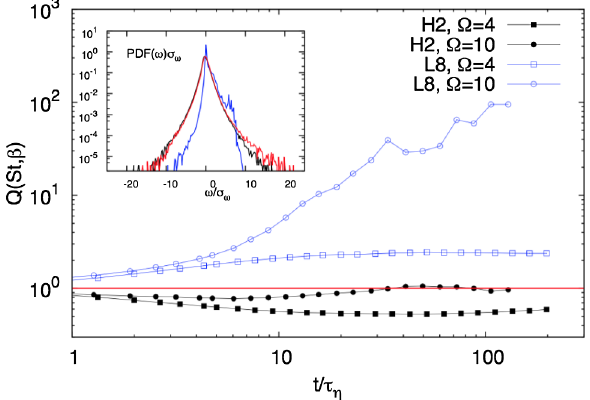
FIG. 9. A measure of the inertial particles ’ preferential sam- pling of the vorticity regions at low, Ω ¼ 4 , and high, Ω ¼ 10 , rotation rates for two different families: a heavy one H 2 and a light one L 8 . Inset: For the case with Ω ¼ 10 , the probability density function of the vertical vorticity ω x normalized to its standard deviation, as measured at the positions of light particles L 8 (blue), heavy particle H 2 (black), and tracers T 0 (red). Data refer to DNS at resolution N ¼ 2048